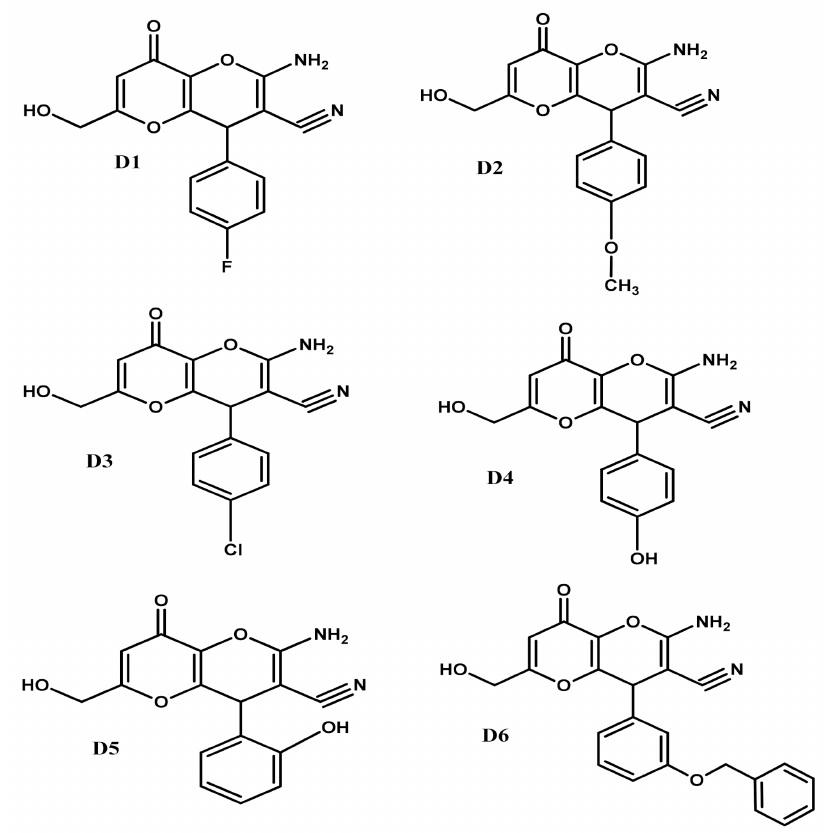
Figure 3. Molecular structure of the six KA derivatives (D1 to D6) analyzed during the MD